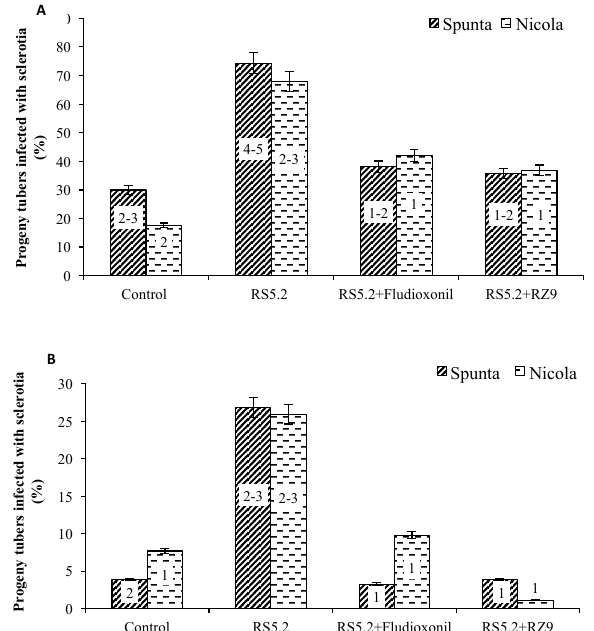
Figure 4. Relative weight of infected potato daughter tu - bers (%) in field trials conducted in the Sned-Gafsa region for potato cvs ′Spunta′ and ′Nicola′ during two growing seasons in 2012 ( A ) and 2013 ( B ). Bars represented stand- ard errors. The percentage of infected daughter tubers rep- resents the proportion of infected daughter tuber weight compared with the total weight of daughter tubers. RZ9: Pseudomonas aeruginosa ; RS5.2: Rhizoctonia solani ; fludiox - onil: chemical fungicide. Values inside the histograms rep- resent the black scurf severity